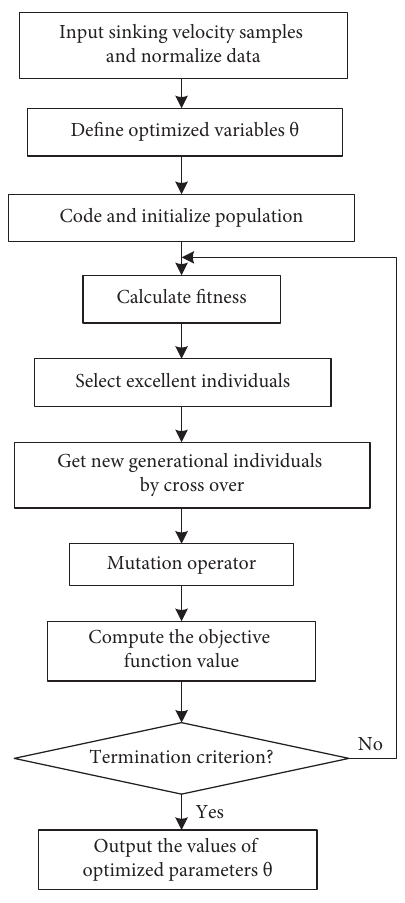
Figure 1: Optimization process of correction coefficient based on the genetic